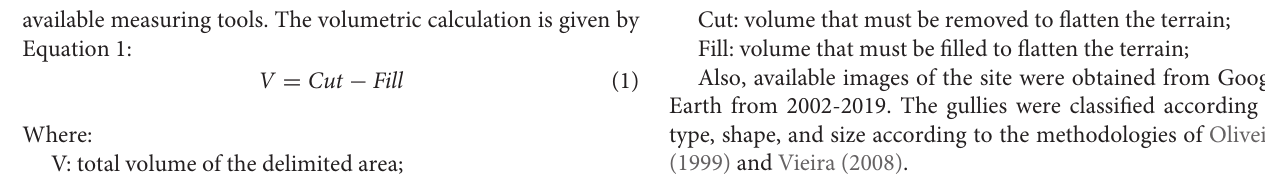
available measuring tools. The volumetric calculation is given